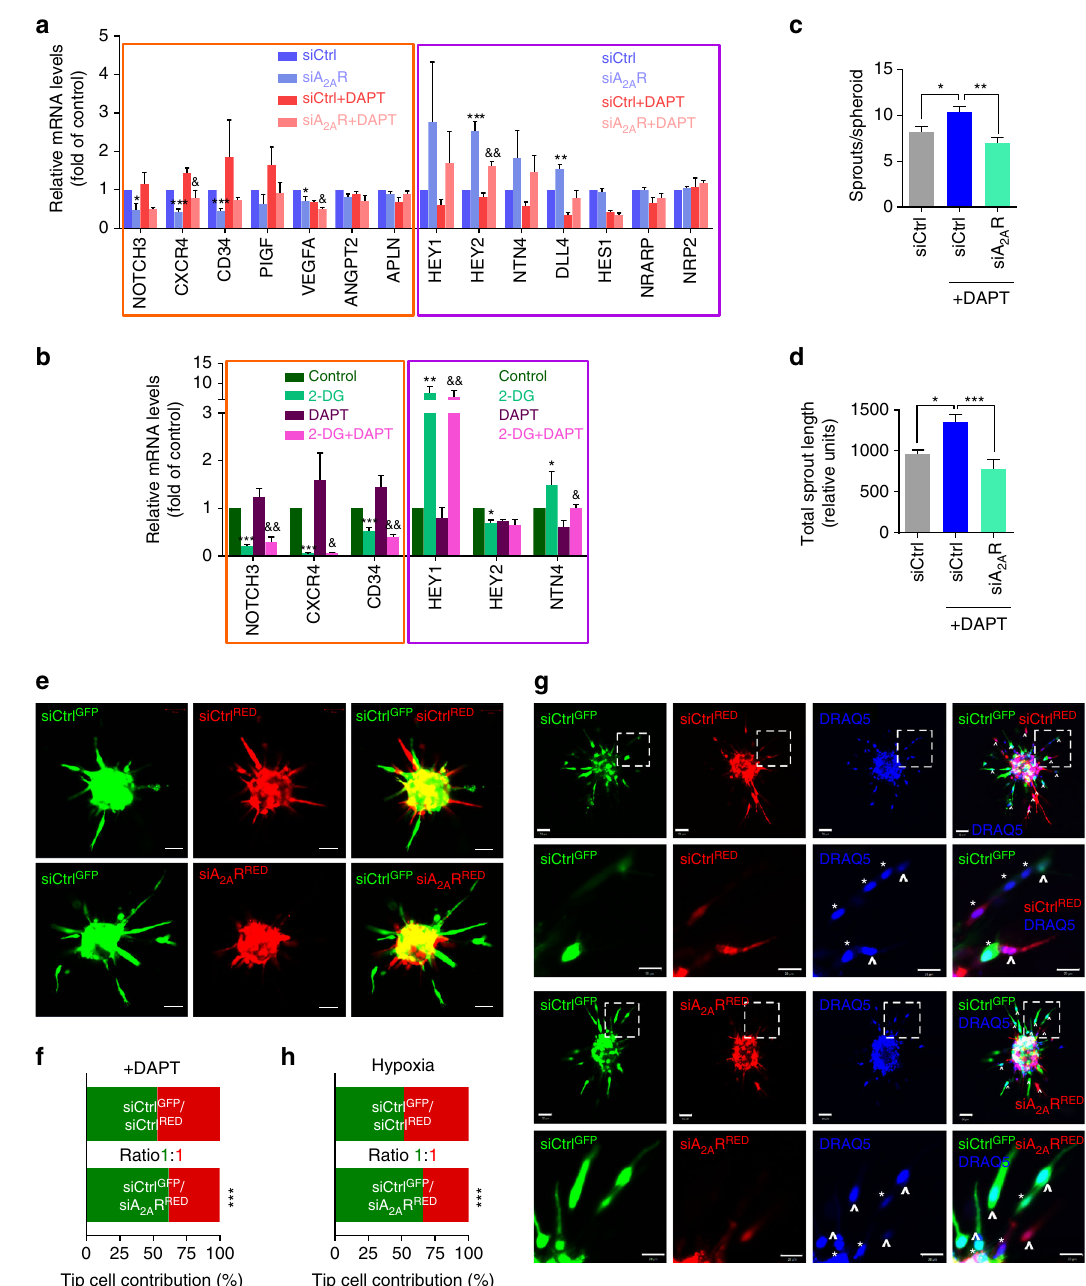
Fig. 7 ADORA2A regulates HRMEC tip cell formation. a Real-Time PCR analysis of the mRNA levels of the sprouting-governing genes in HRMECs transfected with siA 2A R or siCtrl, in the presence or absence of DAPT ( n = 3; * P < 0.05; ** P < 0.01; *** P < 0.001 vs. siCtrl; & P < 0.05, && P < 0.01 vs. siCtrl + DAPT). b Real-Time PCR analysis of the mRNA levels of the sprouting-governing genes in 2-DG-treated HRMECs in the presence or absence of DAPT ( n = 4; * P < 0.05; ** P < 0.01; *** P < 0.001 vs. vehicle control; & P < 0.05, && P < 0.01 vs. DAPT). c , d Morphometric quanti fi cation of spheroid sprouting from cells transfected with siCtrl or siA 2A R in the presence or absence of DAPT. n = 10 per group. n is number of spheroids quanti fi ed. * P < 0.05; ** P < 0.01; *** P < 0.001. e Representative fl uorescence photographs of EC spheroids containing a 1:1 mixture of siCtrl GFP and siCrl RED ECs, or a 1:1 mixture of siCtrl GFP ECs and ECs with siA 2A R RED in the presence of DAPT. Scale bars , 100 μ m. f Quanti fi cation of the fraction of tip cells with the indicated genotypes shown in e ( n = 10; *** P < 0.001 vs. siCtrl GFP ). g Representative fl uorescence photographs of mosaic EC spheroids containing a 1:1 mixture of siCtrl GFP ECs and siA 2A R RED ECs under hypoxia conditions. Cells were stained with DRAQ5 ( blue ) to mark EC nuclei. Tip cells are indicated by “ ^ “ ; Stalk cells are indicated by “ * “ . The 2nd and 4th rows are magni fi cation of the boxed regions in the 1st and 3rd rows , respectively. Scale bar : 50 μ m ( 1st and 3rd rows) and 20 μ m ( 2nd and 4th rows). h Quanti fi cation of the fraction of tip cells with the indicated genotypes shown in g ( n = 10 per group). *** P < 0.001 vs. siCtrl GFP . Data are represented as means ± s.e.m. Statistical signi fi cance was determined by unpaired Student ’ s t -test (for a , b , f , h ) and one-way ANOVA followed by Bonferroni test (for c , d